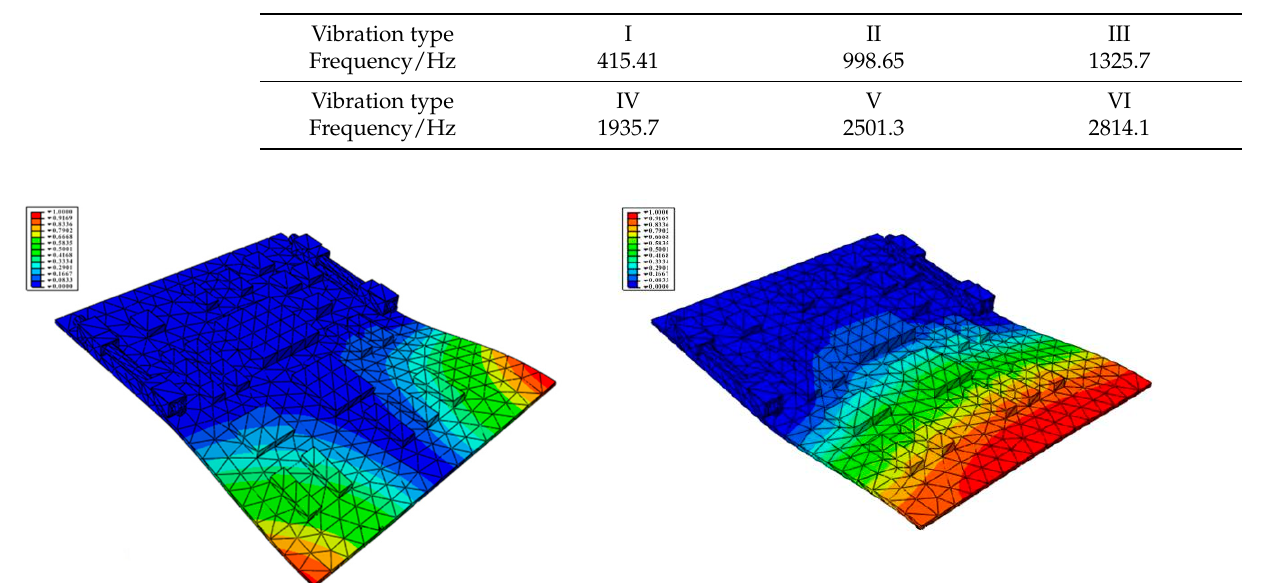
Table 2. First six natural frequencies of CPU board.